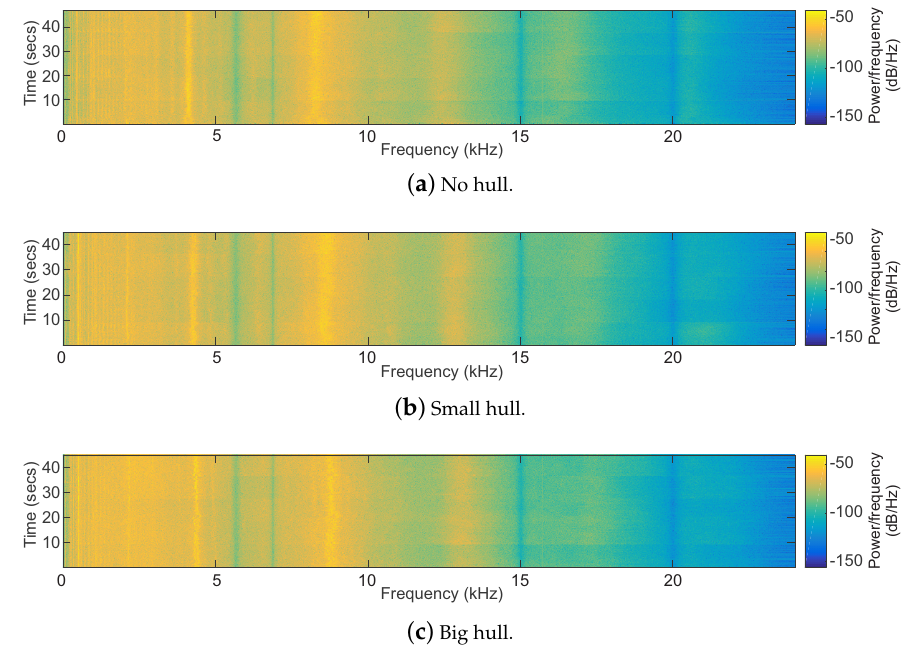
Figure 6. Altitude flight with no hull, a small hull, and a big